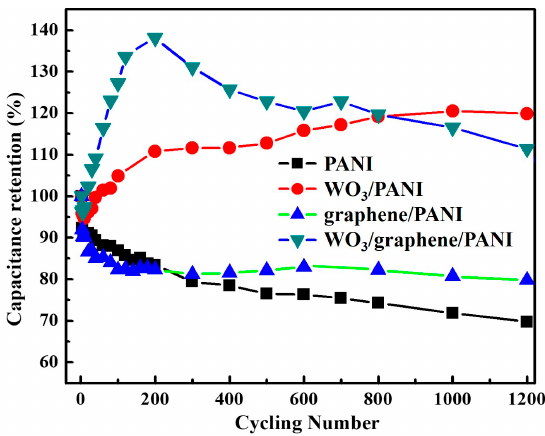
Figure 9. Cycling stability of pristine PANI, WO 3 /PANI, graphene/PANI, and WO 3 /graphene/PANI film electrodes at 0.16 mA / cm 2 for 1200 cycles in 0.5 M H 2 SO 4 aqueous solution.